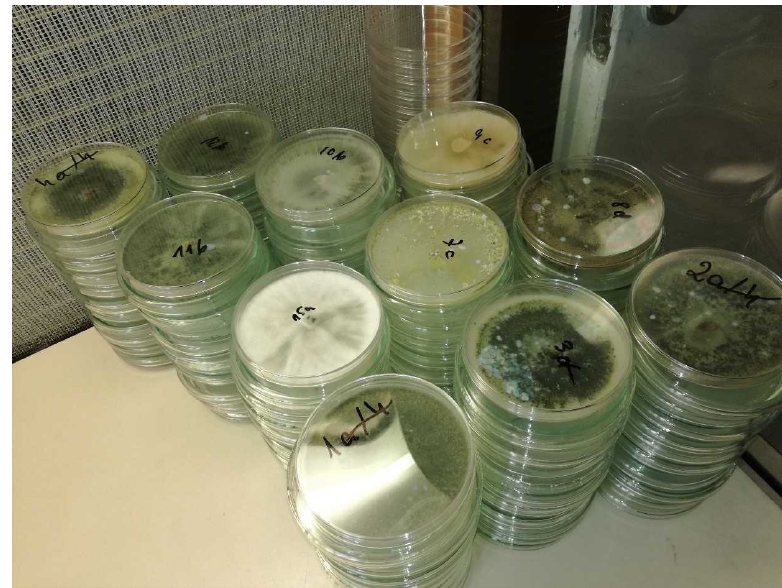
Figure 2. Trichoderma spp. isolates on Petri dishes.